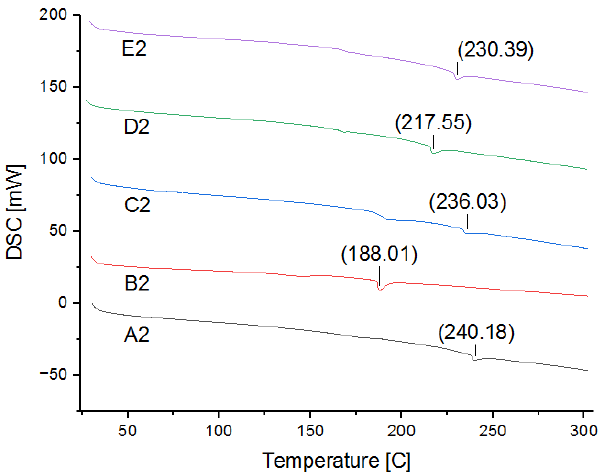
Figure 13. The results of the DSC test showing the percentage variation in the resin–catalyst matrix: (A 2 ) 99.5%:0.5; (B 2 ) 99%:1%; ( C 2 ) 98.5%:1.5%; (D 2 ) 98%:2%; (E 2 ) 97.5%:2.5%.